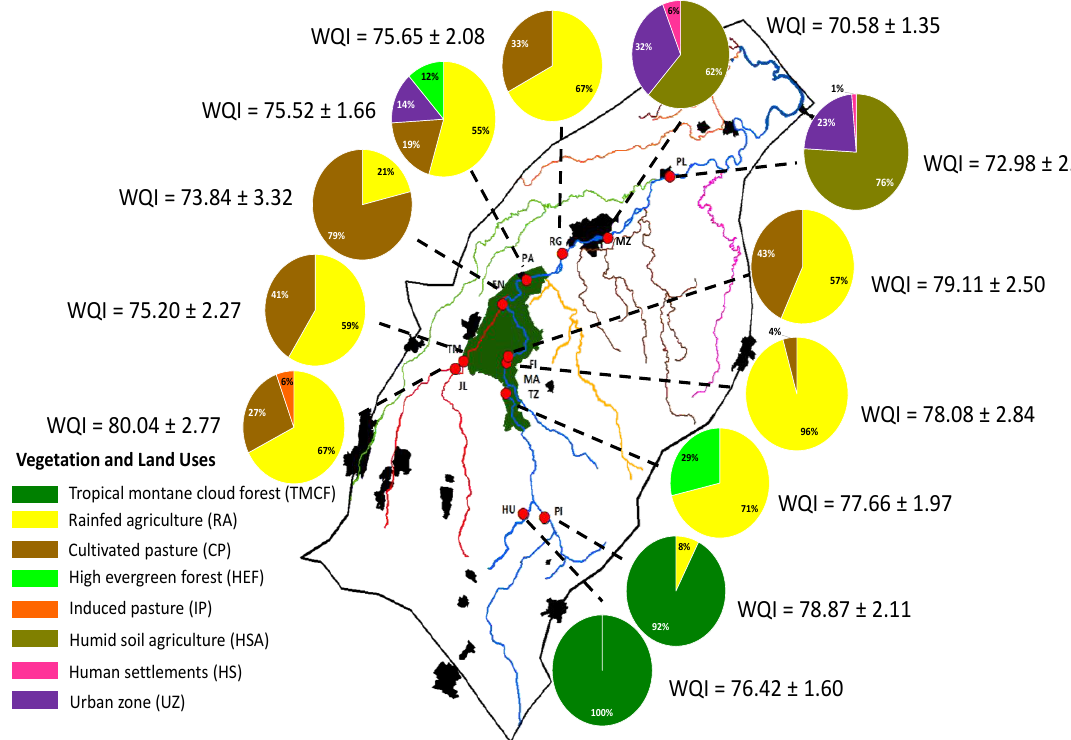
Figure 6. Percentage of land uses from buffer and mean WQI of study sites along the Bobos River. Tributaries and streams are shown in colors as in Figure 1.